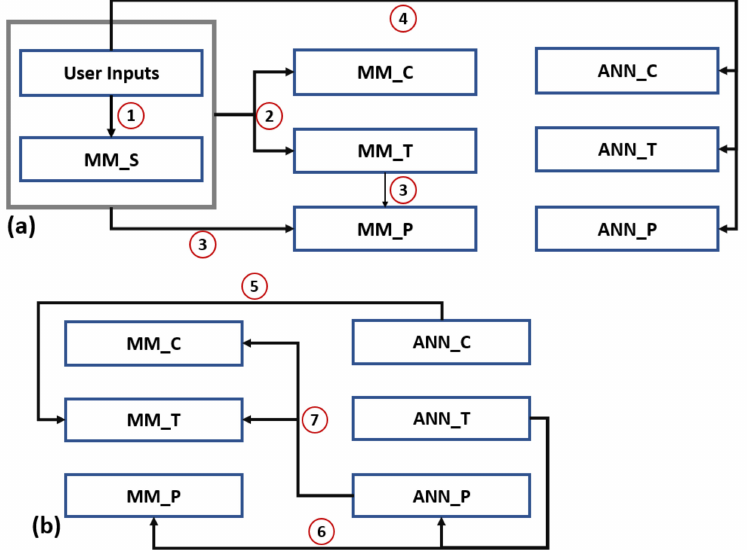
Figure 8. Overall schematic flow chart of hybrid model algorithm: ( a ) establish theoretical models and ANN models by using user inputs and slag chemistry models; ( b ) hybrid architecture consisting of theoretical models and ANN